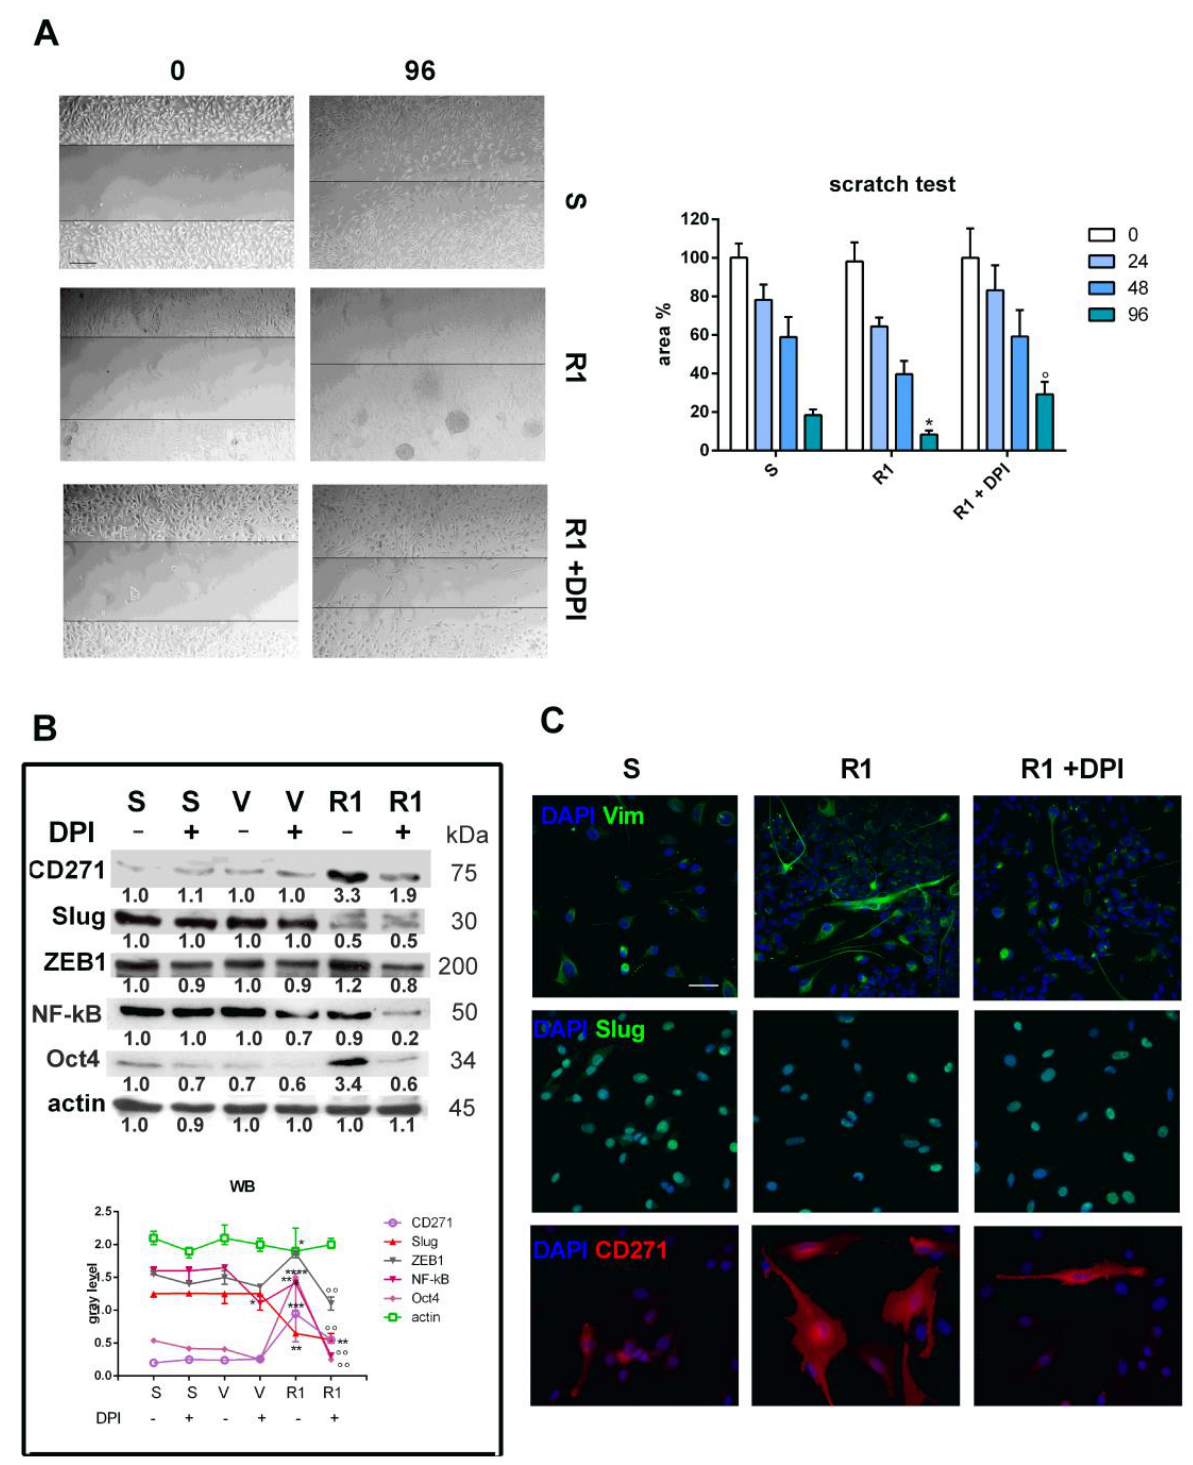
Figure 3. Effect of Nox inhibition on cell migration and EMT of SK-MEL-28 melanoma cells induced or not induced to drug resistance. ( A ) Representative images (scale bar = 100 µ m) of migration